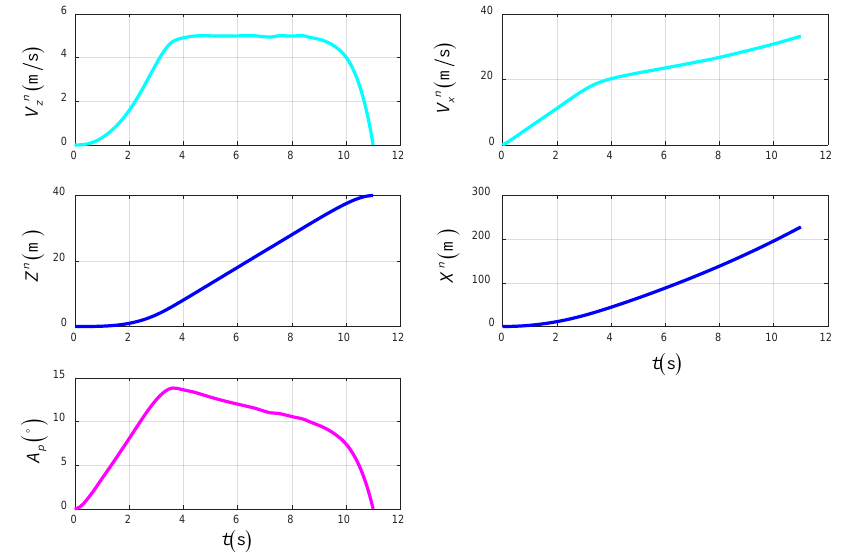
Figure 21. The state variables in TTO.